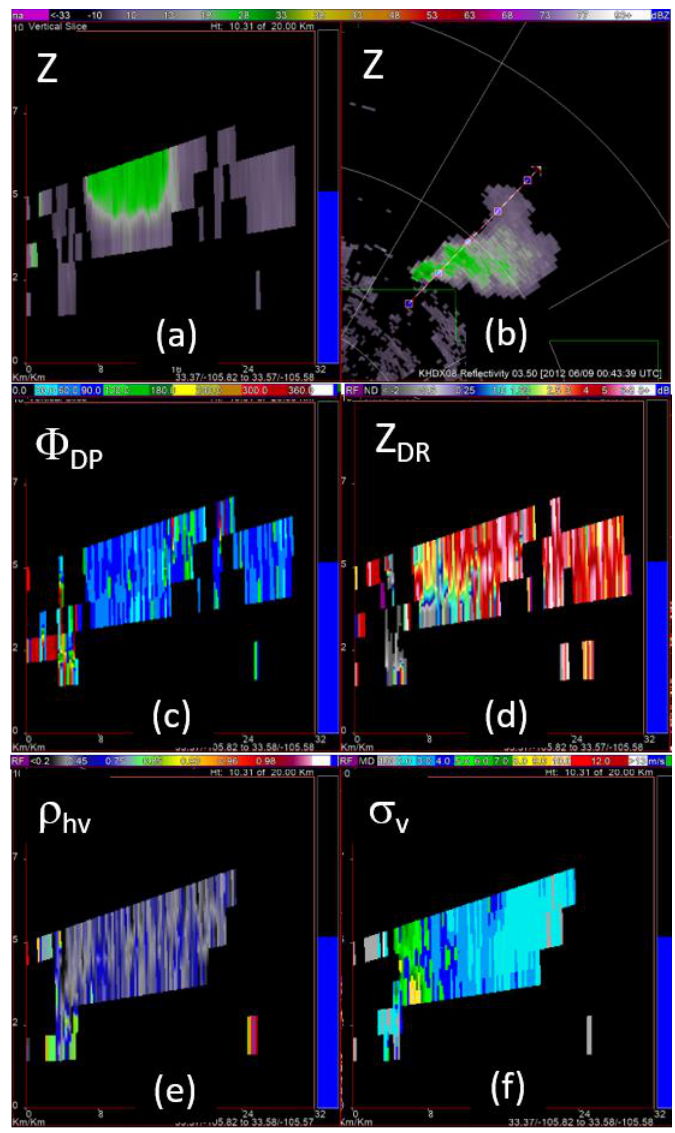
Figure 14. ( a ) Vertical cross section of Z through the plume. ( b ) Field of Z plotted as PPI (Plan Position Indicator) at the elevation of 3.5°, the arrow indicates location of the vertical cross sections. ( c ) Same as in ( a ) except the differential phase is shown. ( d ) Same as in ( a ) but the cross section is of differential reflectivity. ( e ) RHI of the correlation coefficient. ( f ) Same as in ( a ) but the plot shows the spectrum width. The top color bar indicates values of reflectivity (dBZ), the second from top color bar (above the Φ DP field) indicates the values of differential phase (deg), the third color bar (above the Z DR field) depicts values of Z DR (dB), the color bar above the field of ρ hv indicate its categories, and the bar above σ v depicts values of the spectrum width. The ground altitude at the fire location is 2.9 km above mean sea level. Radar time is 00:43 UTC and the range rings are at 30, 60 and 90 km.